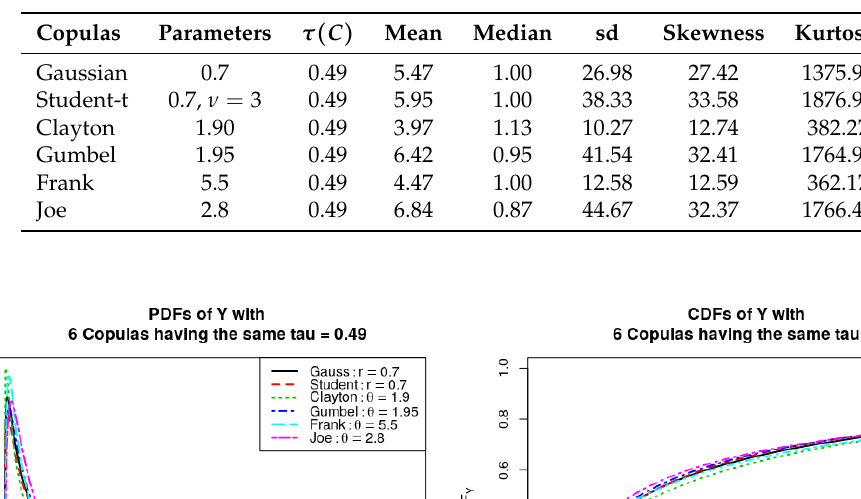
Table 7. Descriptive Statistics for Y = X 1 X 2 in which ( X 1 , X 2 ) is modeled with six copulas having the same Kendall coefficient τ = 0.49.